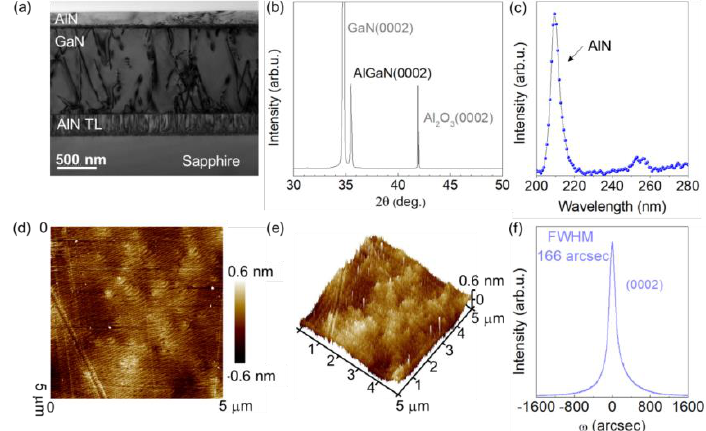
Figure 1. ( a ) Brightfield cross-sectional TEM images of AlN/GaN heterojunctions grown by MOCVD. ( b ) XRD pattern of the top AlN/GaN heterojunctions. ( c ) PL spectrum of the top AlN epitaxial layer. ( d ) AFM image of the AlN surface morphology. ( e ) Three-dimensional AFM surface topography of the AlN epitaxial layer. ( f ) ω -scan rocking curve of the AlN (0002) symmetric plane.